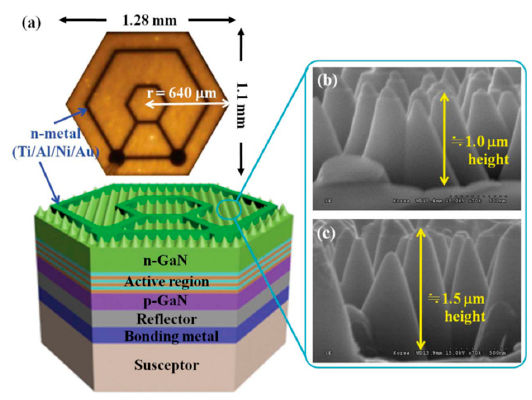
Figure 17. Honeycomb-type VLED with a textured cone-shaped deep-pillar surface [139].